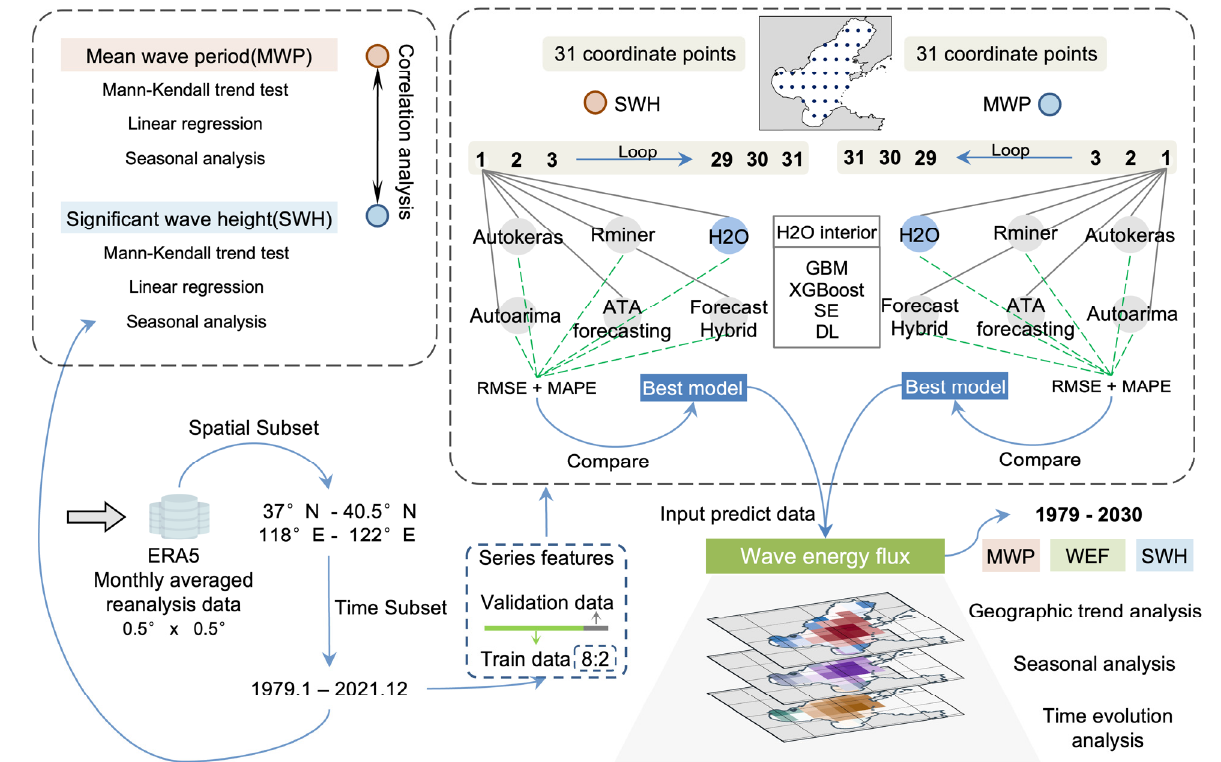
Figure 1. Summary of research, including data processing, statistical analysis, and modeling proce- dures.